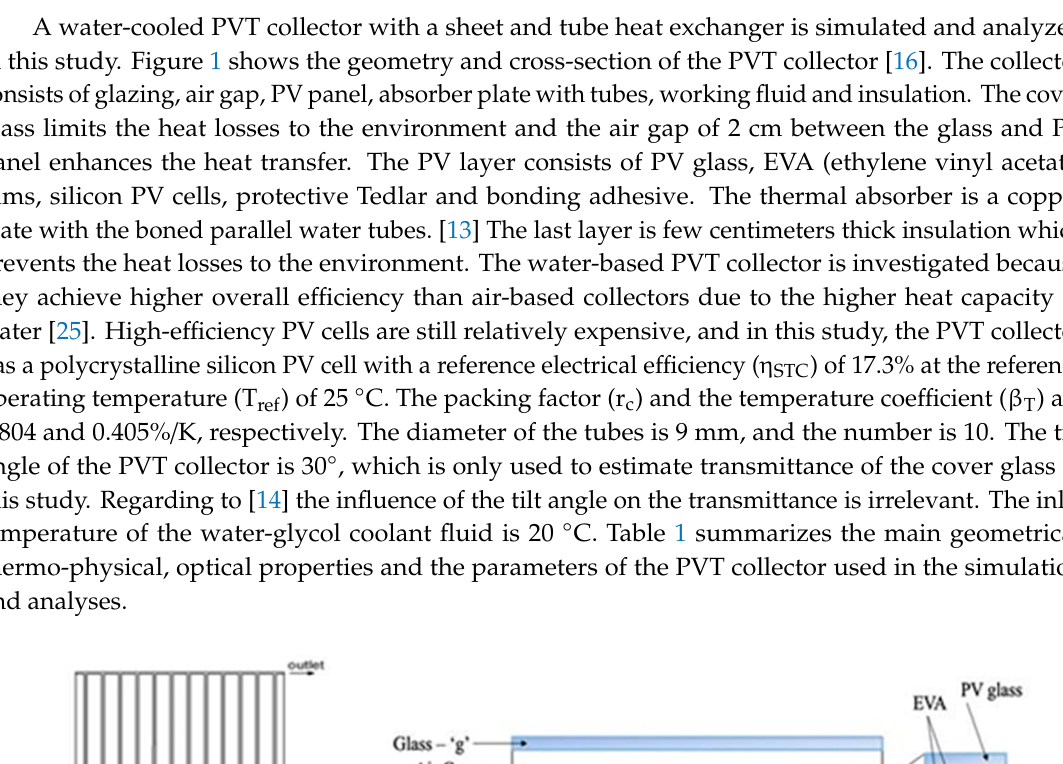
Table 1. The geometrical, thermo ‐ physical and optical properties of the photovoltaic ‐ thermal (PVT) collector.